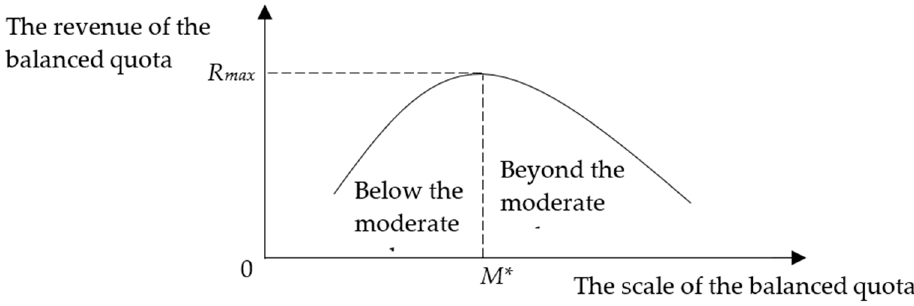
Figure 1. The inverted u-shaped curve diagram of balanced quota’s scale and revenue.